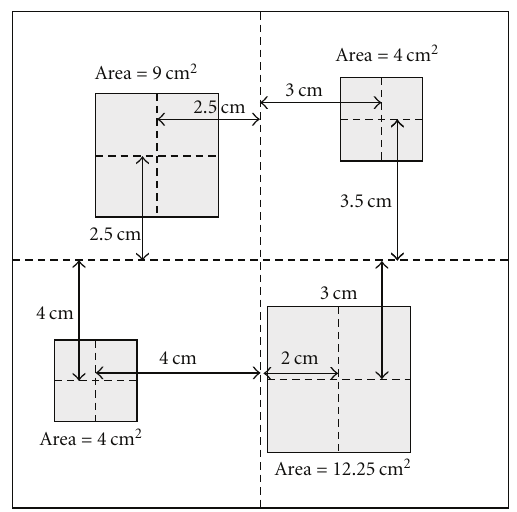
Figure 4: The hypothetical example screen showing inputs required to compute the balance